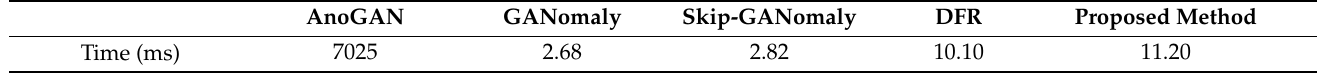
Table 4. Inference Time of AnoGAN, GANomaly, Skip-GANomaly, and the proposed method. AnoGAN GANomaly Skip-GANomaly DFR Proposed Method